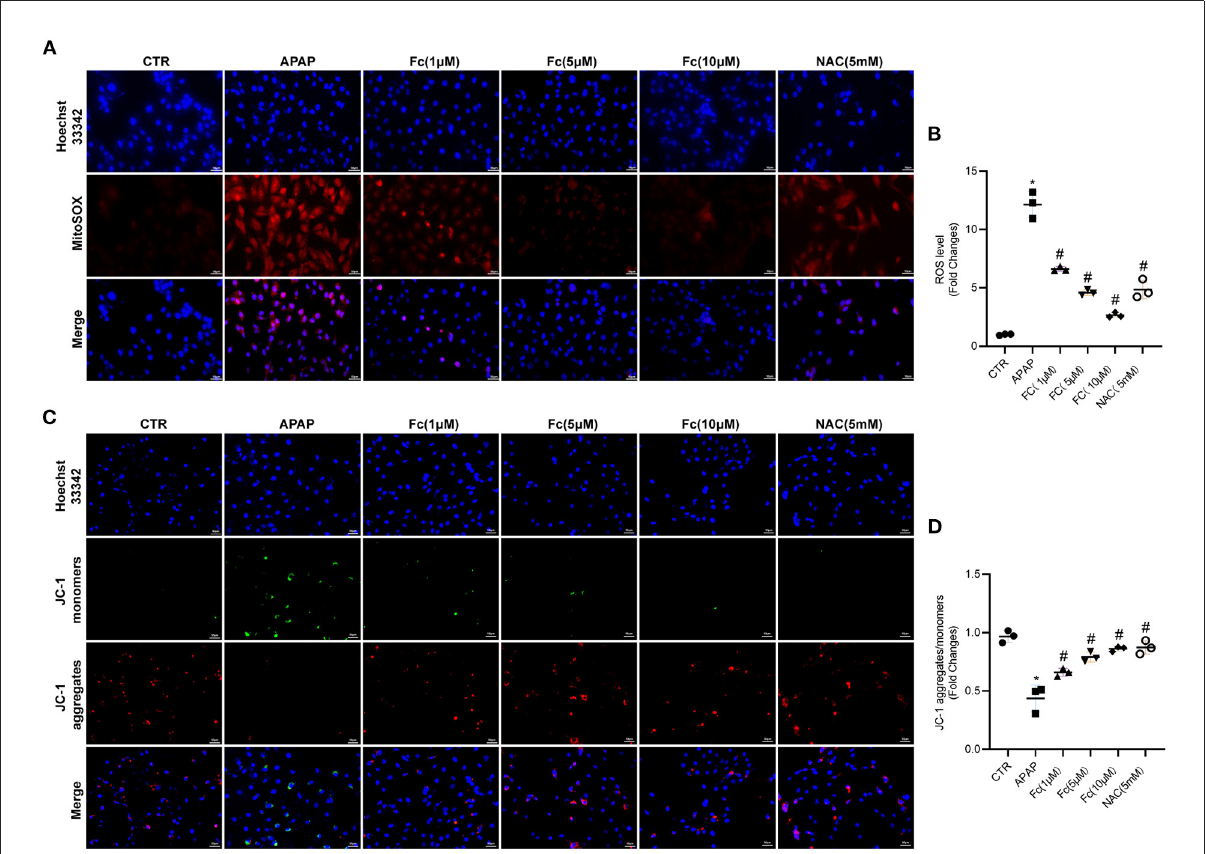
FIGURE6 Effects of Notoginsenoside Fc on the intracellular oxidative stress and mitochondrial dysfunction triggered by APAP in HK-2 cells. (A,B) Representative images and semiquantitative analysis of mitochondrial ROS production in HK-2 cells (original magnification × 200, bars = 50 µ m). (C,D) Representative images and semiquantitative analysis of mitochondrial membrane potential levels in HK-2 cells (original magnification × 200, bars = 50 µ m). Results were expressed as mean ± SD. * P < 0.05 vs. control group. # P < 0.05 vs. APAP